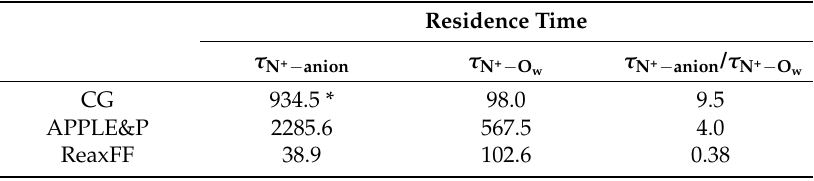
Table 2. Characteristic residence times (in ps) of anion and H 2 O and their ratio.